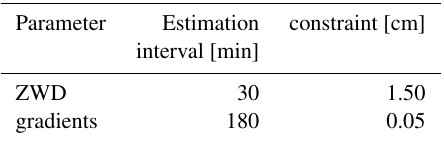
Table 3. Parametrization of the tropospheric estimates for the refer- ence solution.